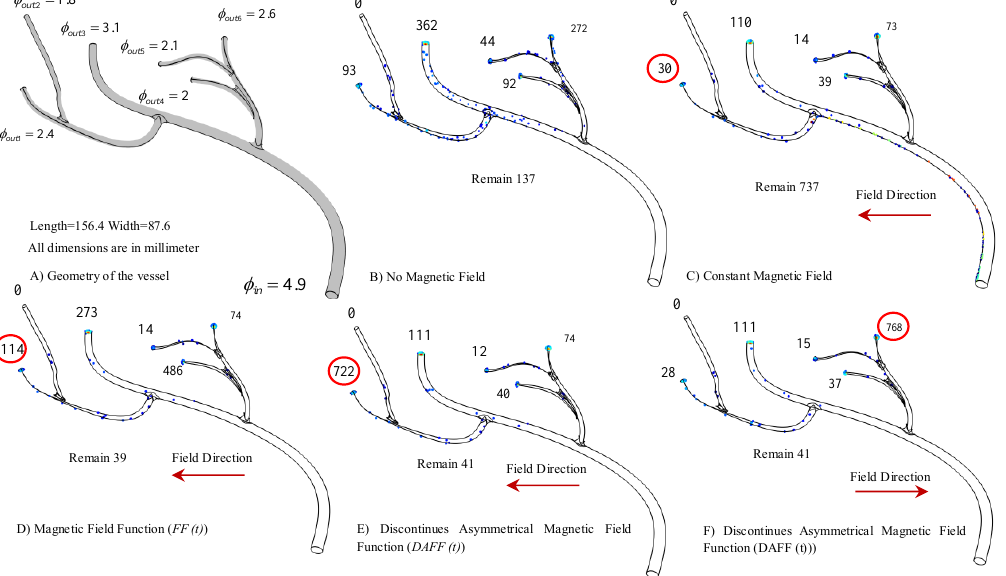
Figure 10. The simulation of the magnetic nanoparticles’ (MNPs’) distribution in a realistic vessel under the different designed actuation functions. The number close to each outlet is the number of particles reaching that outlet: ( A ) the realistic vessel geometry; ( B ) the distribution of particles under a drag force in the absence of a magnetic field; ( C ) a constant magnetic field; ( D ) the field function (FF); ( E ) the discontinuous asymmetrical